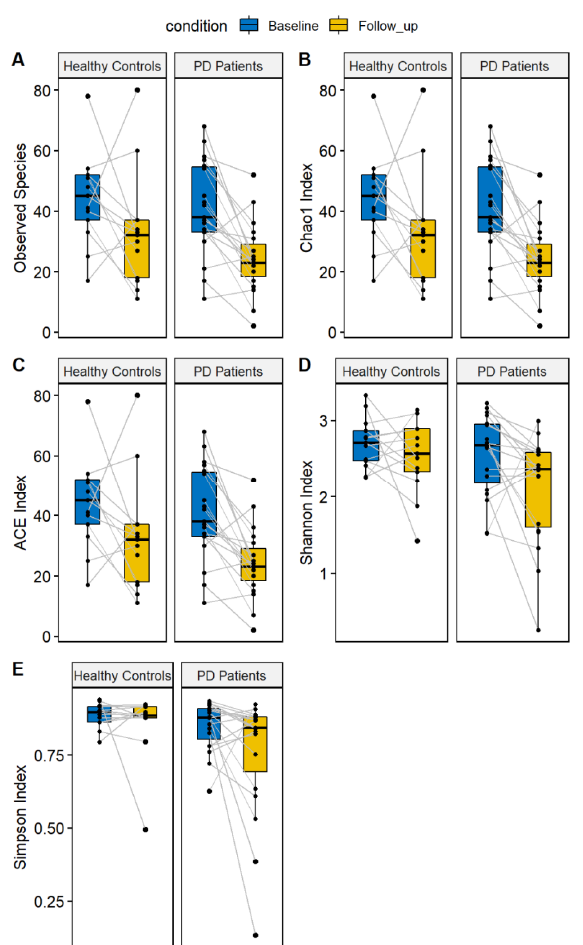
Figure 1. Alpha diversity indices evaluated for Parkinson’s disease patients and healthy controls. The following indices are reported: number of observed species ( A ), Chao1 index ( B ), ACE index ( C ), Shannon Index ( D ), and Simpson Index ( E ). For both patients and controls, the values at the first visit (“baseline”, colored in blue) and the follow-up (colored in yellow) are